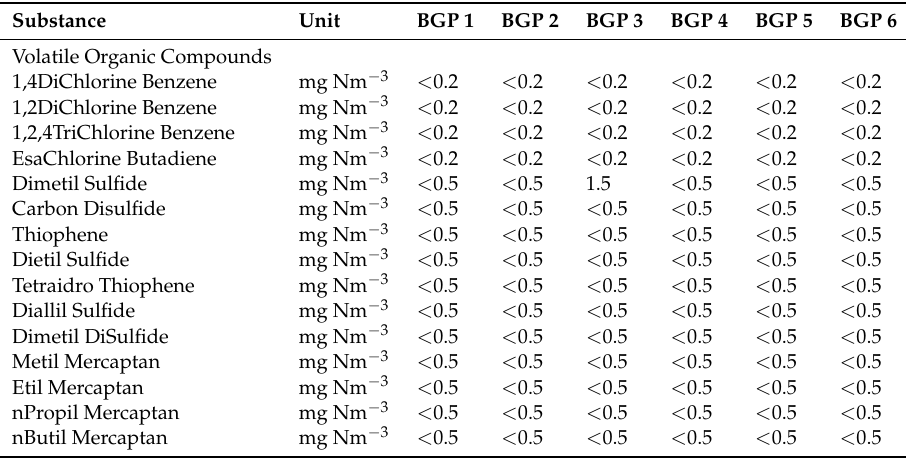
Table 13. Biogas composition—part